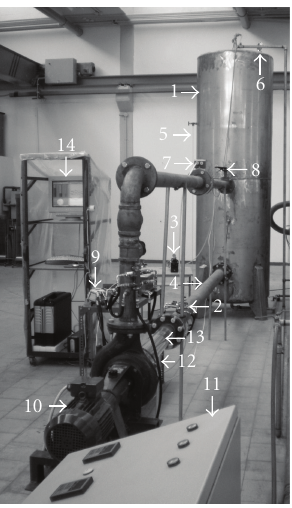
Figure 1: The complete experimental setup along with the instru- mentation system.